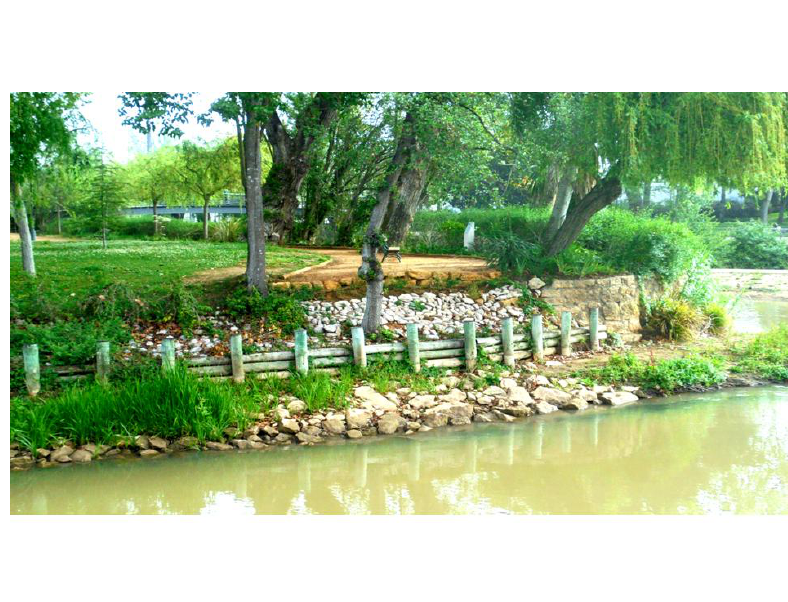
Figure 6b: The elements of natural engineering used in the real situation of renaturalization: Protection of slopes, river banks friendly for animals and plants, trees growing by the water giving the shadow, and many other aspects (Fig. 6a) are necessary today, to pay attention to the nature, improving its living conditions in order to prevent the disastrous floods. Photographed in: Tomar,